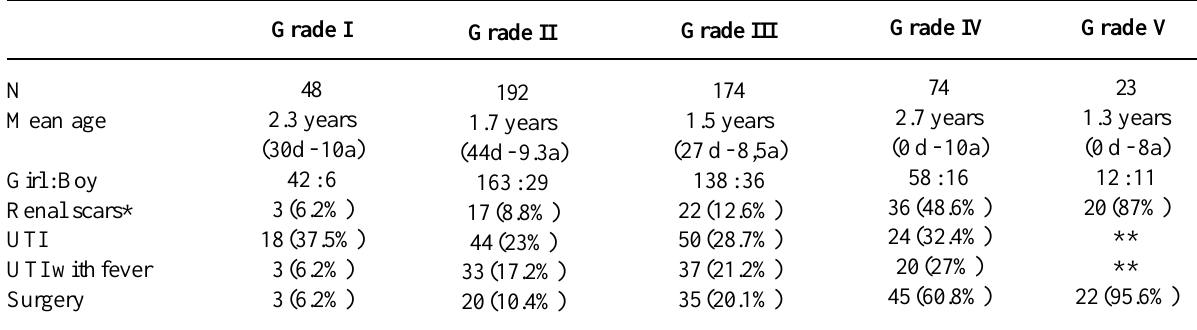
Table 4 – Characteristics of patients studied (n =